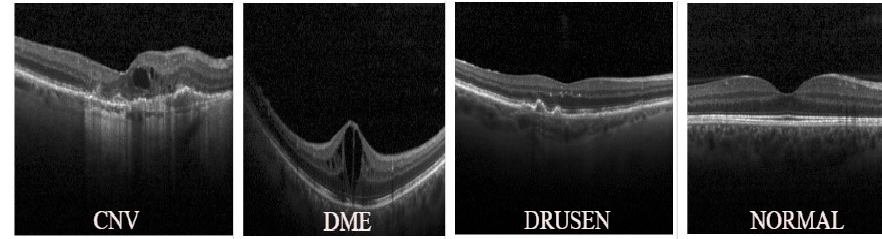
Figure 1. sample OCT Images. Figure 1. Sample OCT